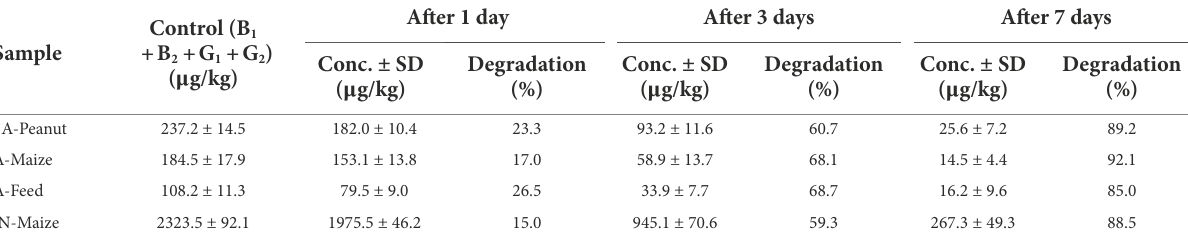
TABLE 2 Aflatoxins degradation by T. reesei CGMCC3.5218 grown on sample substrate.